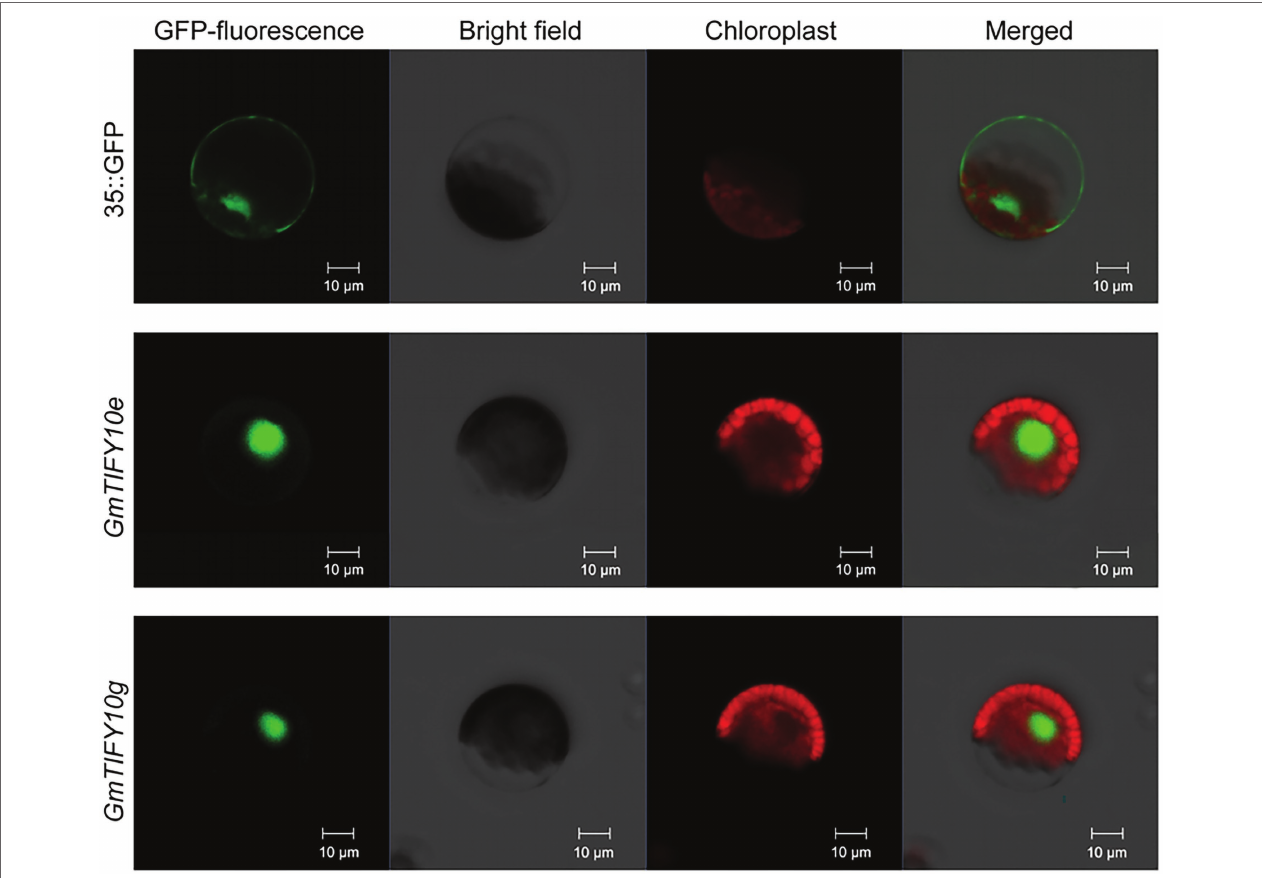
FIGURE 8 | Subcellular localization of GmTIFY10e -hGFP and GmTIFY10g -hGFP fusion protein. 35S::16318hGFP was used as a control. The scale bar of 35S::16318hGFP, GmTIFY10e -hGFP and GmTIFY10g -hGFP indicates 10 μ